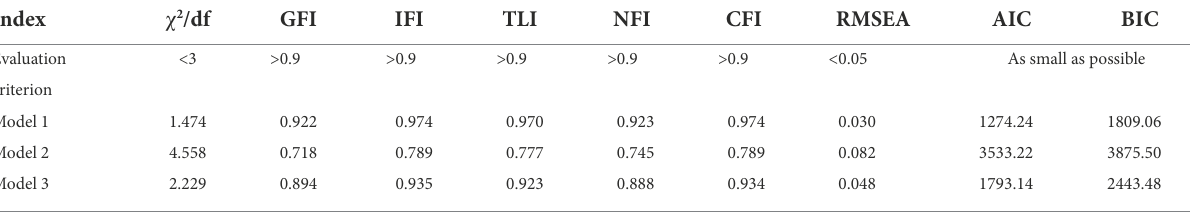
TABLE 5 Model fitting index of confirmatory factor analysis.